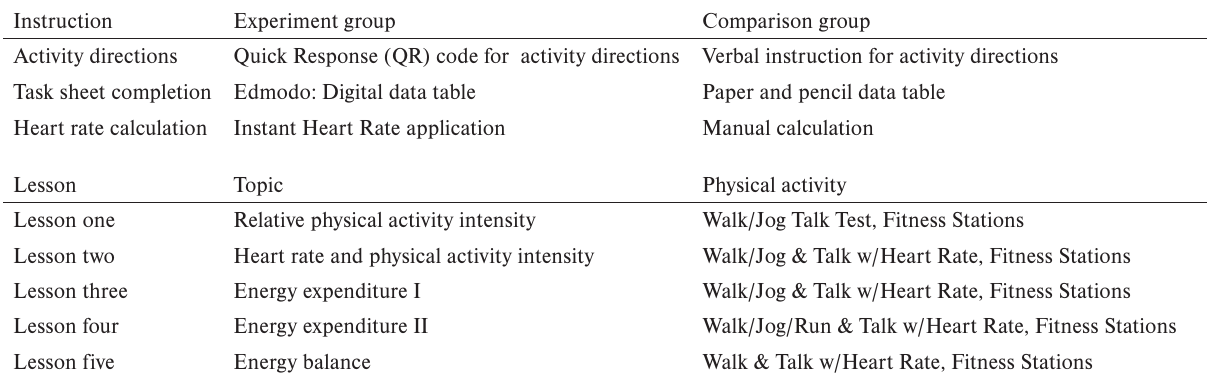
Description of the instructional differences and identical lesson content for the study groups Instruction Comparison